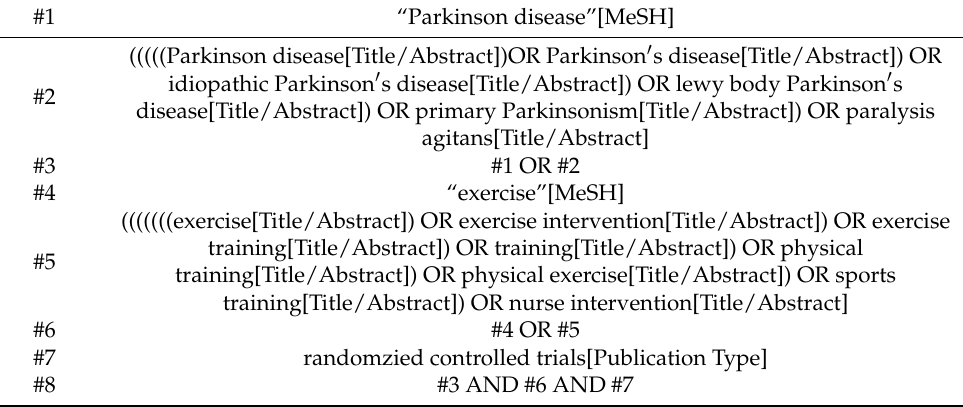
Table 1. Search strategy on